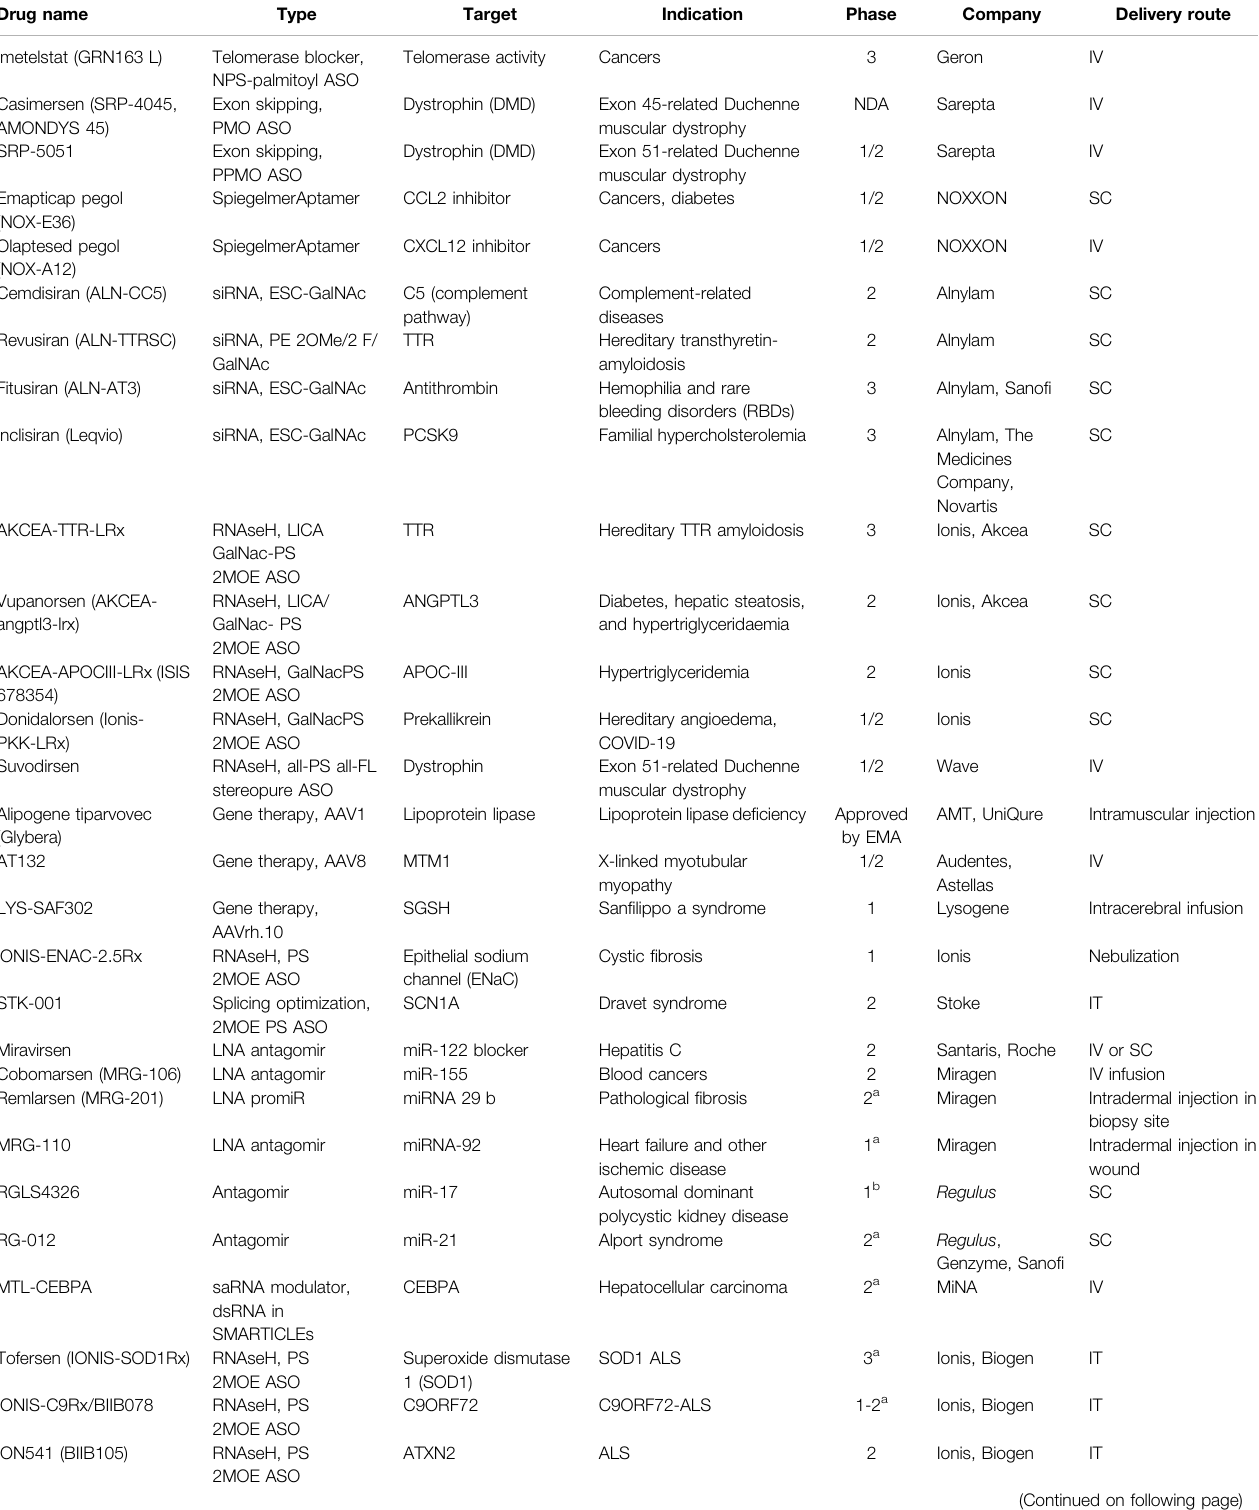
TABLE 2 | Selected nucleic acid – based therapies in clinical trials as of November